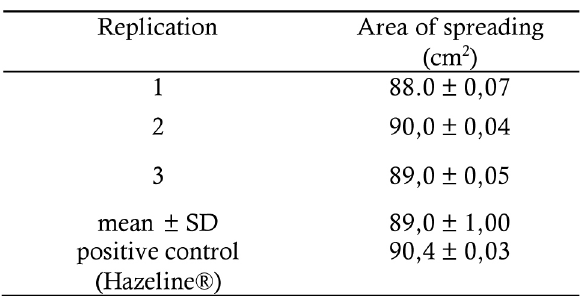
Table 2. Spreading ability of multiple emulsion w/o/w